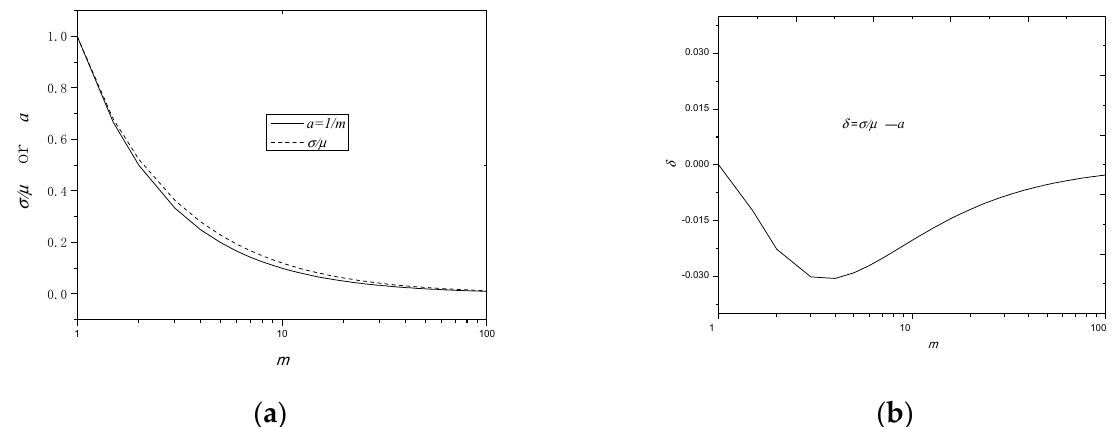
Figure 15. Comparison of the standard error σ / µ with the value of a (or 1 / m ). ( a ) σ / µ and a (or 1 / m ) are dependent on m ; ( b ) δ ( = σ / µ − a ) is dependent on m .